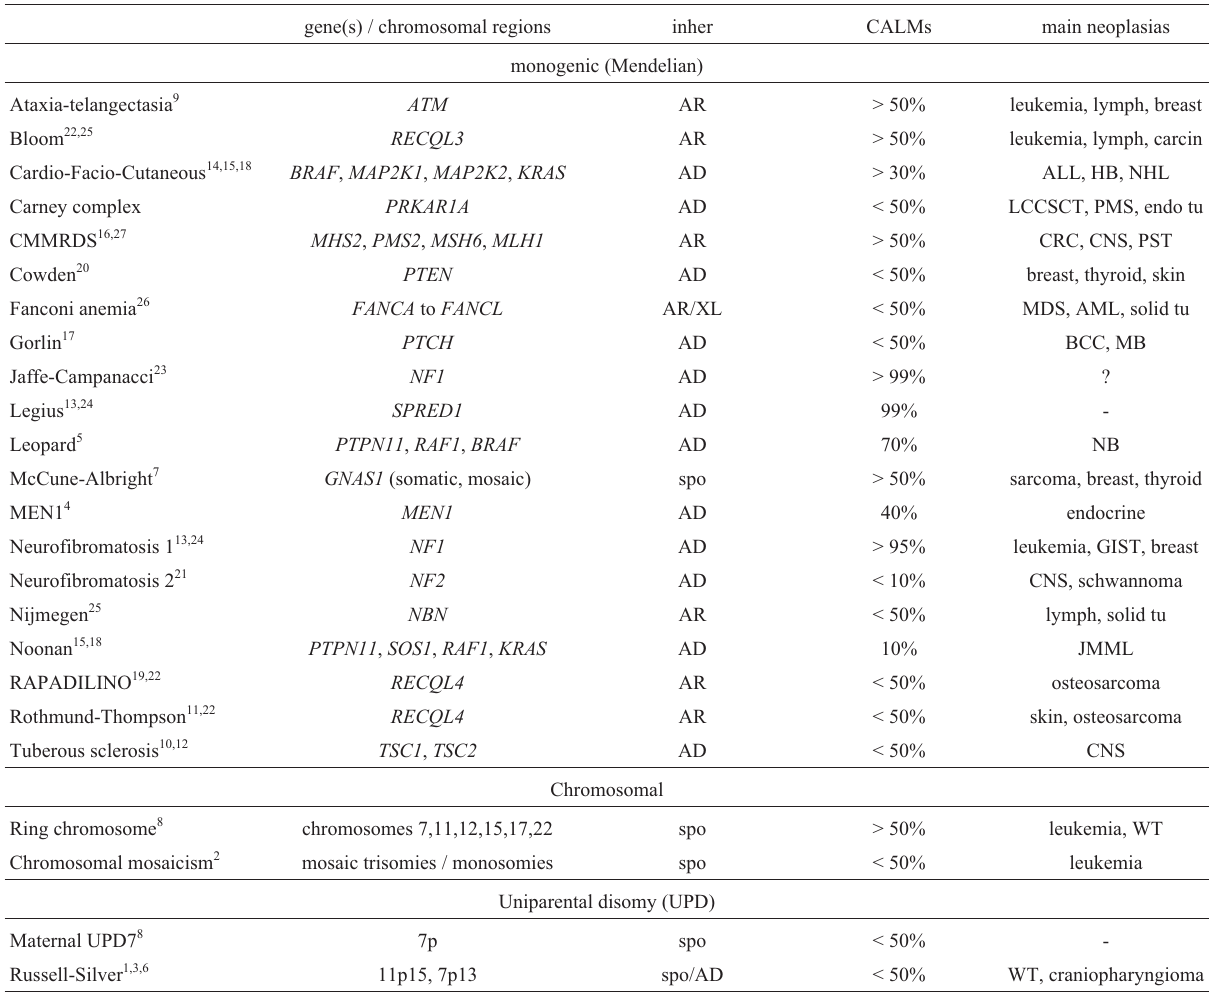
Table 4 - Main syndromes associated with CALMs. gene(s) / chromosomal